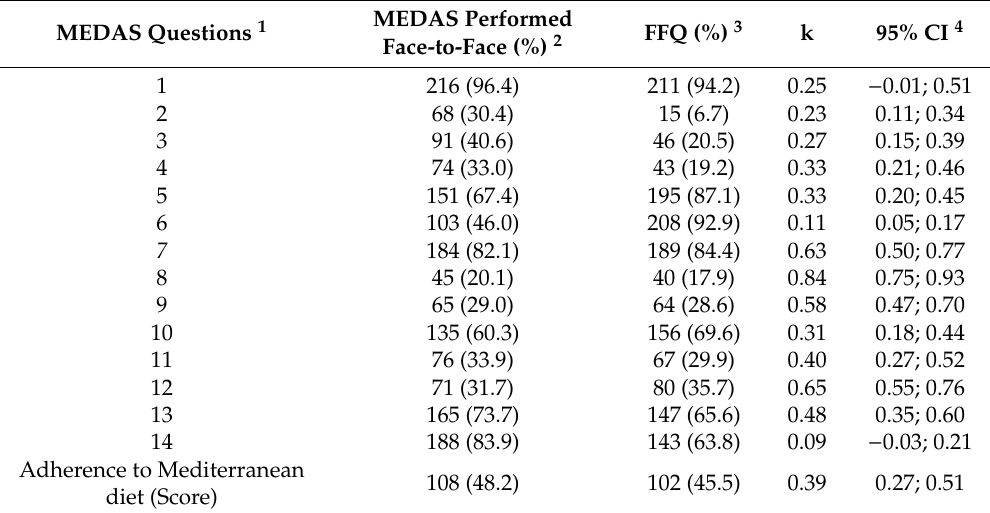
Table 3. Agreement between MEDAS and FFQ